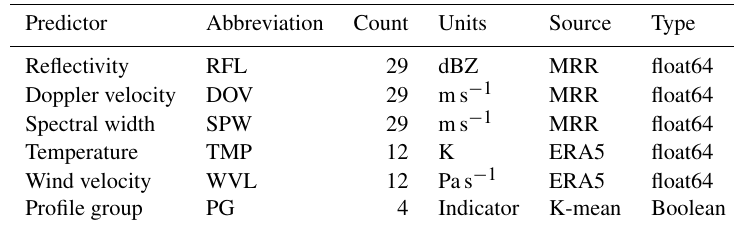
Table 3. Summary of DeepPrecip full vertical column model input